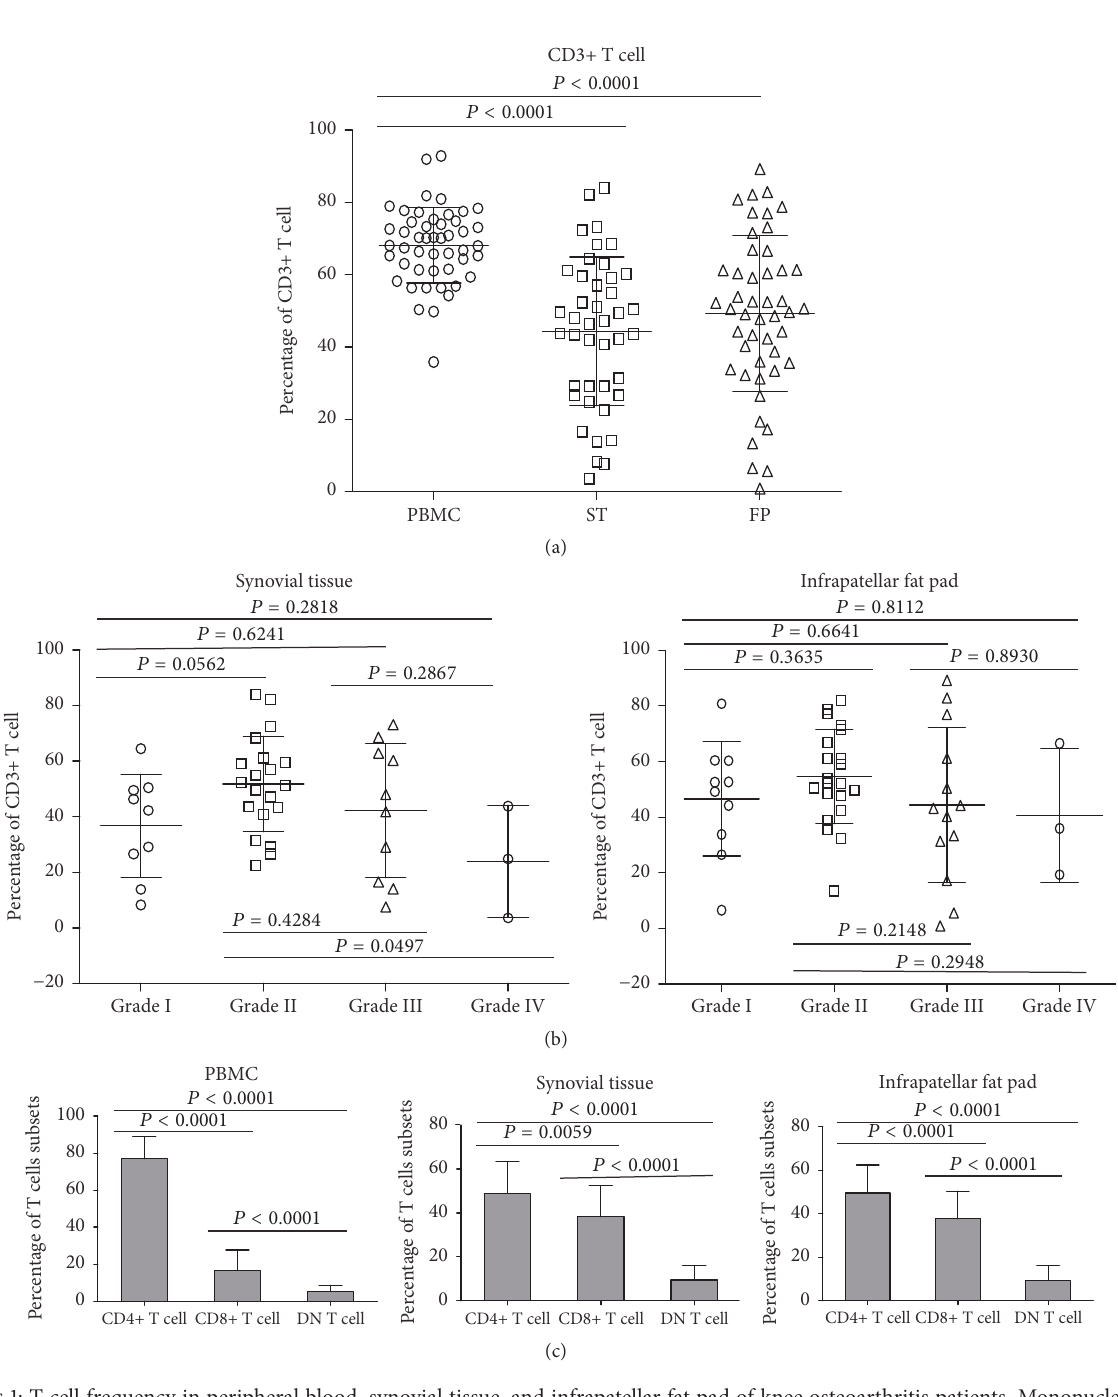
Figure 1: T cell frequency in peripheral blood, synovial tissue, and infrapatellar fat pad of knee osteoarthritis patients. Mononuclear cells were isolated from peripheral blood, synovial tissue, and infrapatellar fat pad. Cells were phenotypically characterized based on CD3+, CD4+, and CD8+ surface expression. (a) Graph comparing CD3+ T cell frequency of total mononuclear cells in peripheral blood ( 𝑁 = 48 ), synovial tissue ( 𝑁 = 42 ), and infrapatellar fat pad ( 𝑁 = 47 ). (b) Graphs showing CD3+ T cell frequency of total mononuclear cells in synovial tissue and infrapatellar fat pad stratified based on Ahlback clinical grading (grades 1–4). Synovial tissue grades I ( 𝑁 = 9 ), II ( 𝑁 = 20 ), III ( 𝑁 = 10 ), and IV ( 𝑁 = 3 ); infrapatellar fat pad grades I ( 𝑁 = 10 ), II ( 𝑁 = 21 ), III ( 𝑁 = 13 ), and IV ( 𝑁 = 3 ). (c) Bar graphs showing composition of different T cell subset (CD4+, CD8+, and DN T cells) frequencies isolated from peripheral blood (PBMC) ( 𝑛 = 48 ), synovial tissue ( 𝑁 = 42 ), and infrapatellar fat pad ( 𝑁 = 47 ). Bars are mean values with error